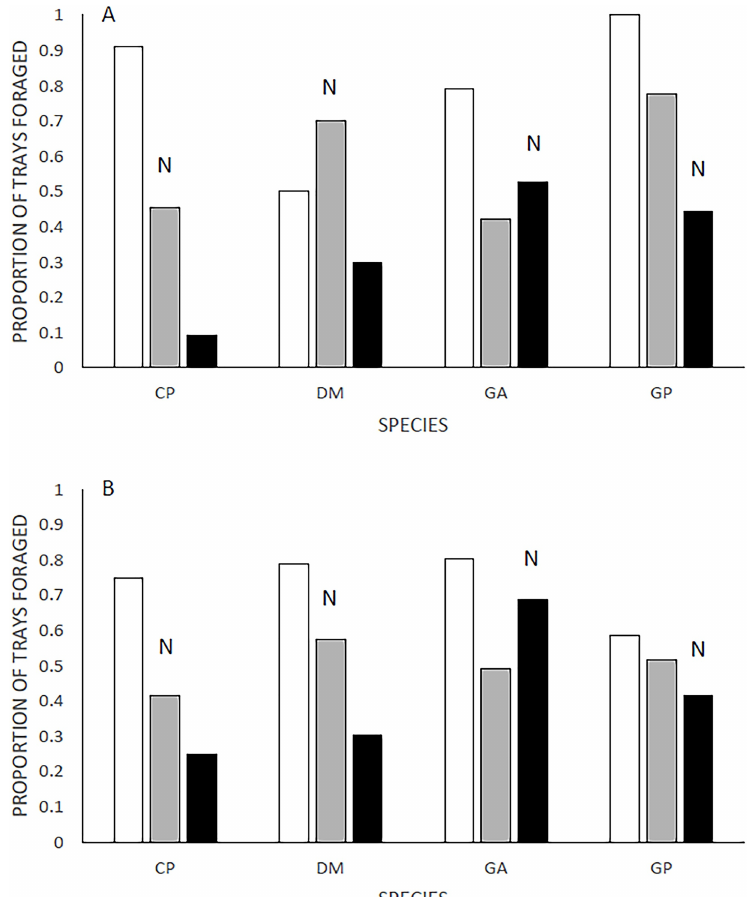
Fig 2. Cumulative proportion (active/total per treatment) of active foraging trays pre- (A) and post-exposure (B). “N” represents the novel snake treatment for each species. Black, gray and white bars represent sidewinder rattlesnakes, Saharan horned vipers and snake-less treatments